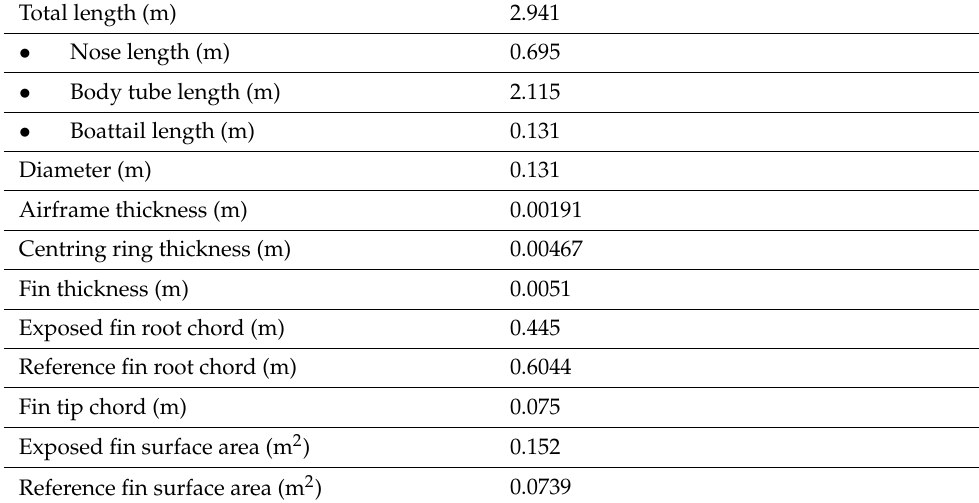
Table 4. Rocket Dimensions.